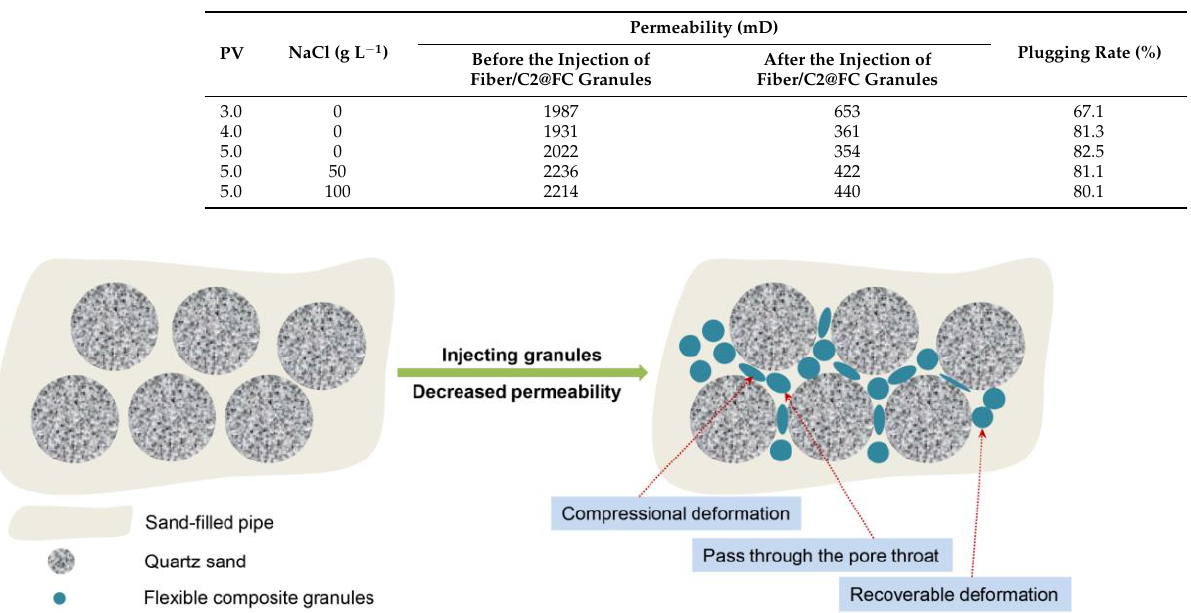
Figure 6. Schematic of flexible composite granules for plugging pore throats.